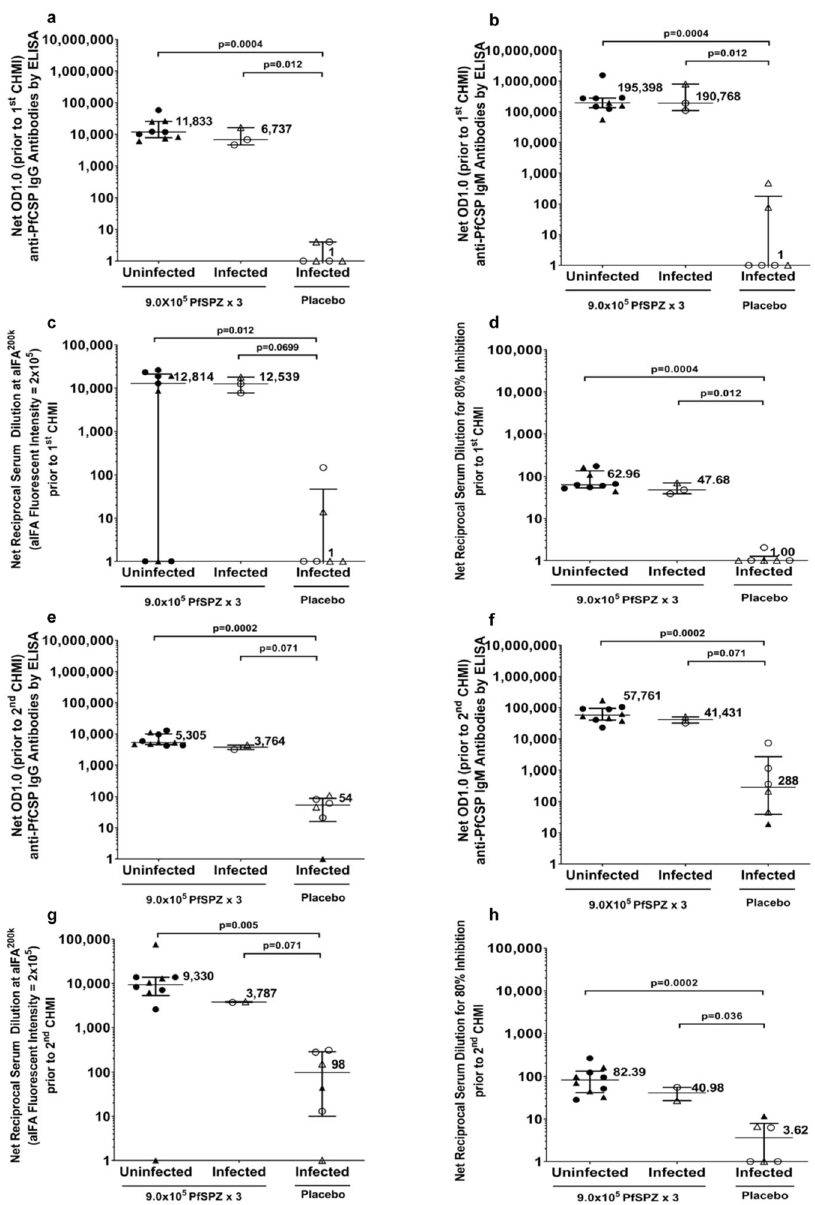
Fig. 3 Antibodies to PfCSP and PfSPZ and functional activity of sera against PfSPZ. a , b Median and interquartile range of net OD 1.0 for IgG and IgM antibodies to PfCSP by ELISA one day prior to CHMI in malaria-naïve adults who were uninfected (protected) and infected